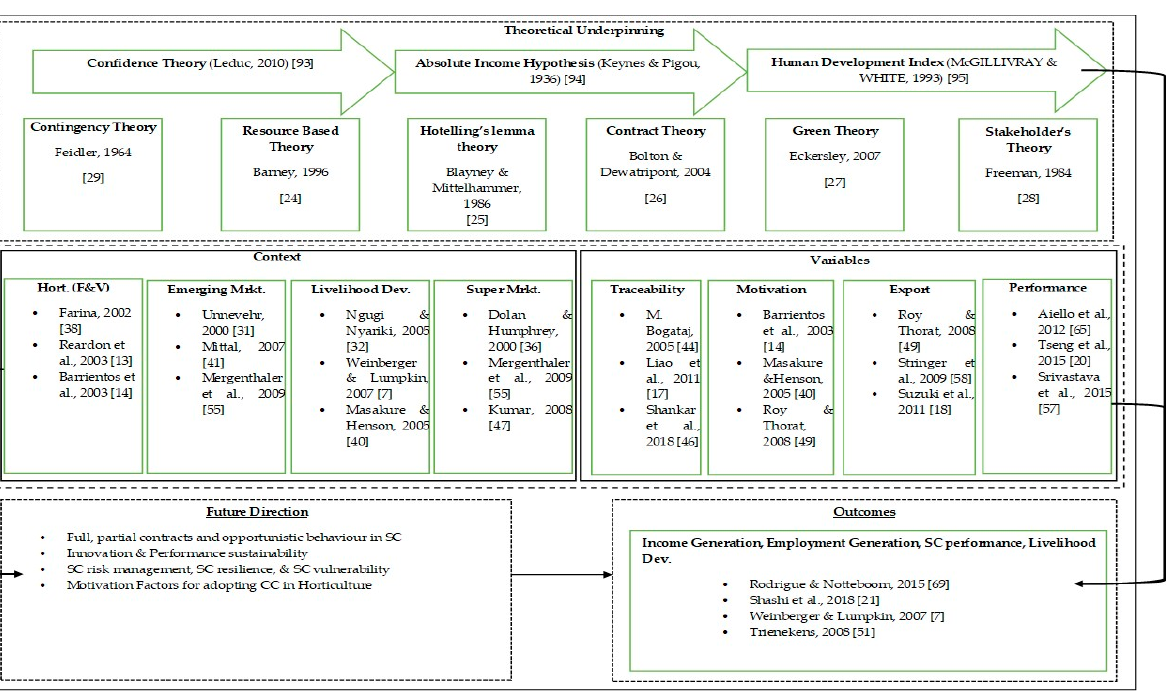
Figure 4. Interventions in Horticulture for livelihoods, Source: The Authors. A CC in horticulture helps achieve sustainability in getting the actual price for agri- products, thereby improving the standard of living for the farmers [35]. Stakeholders must evaluate the influence of CC in horticulture on livelihood development in the context of economics, society, the environment, production, service, and performance sustainability within emerging markets for both short-term and long-term benefits. It is also essential to